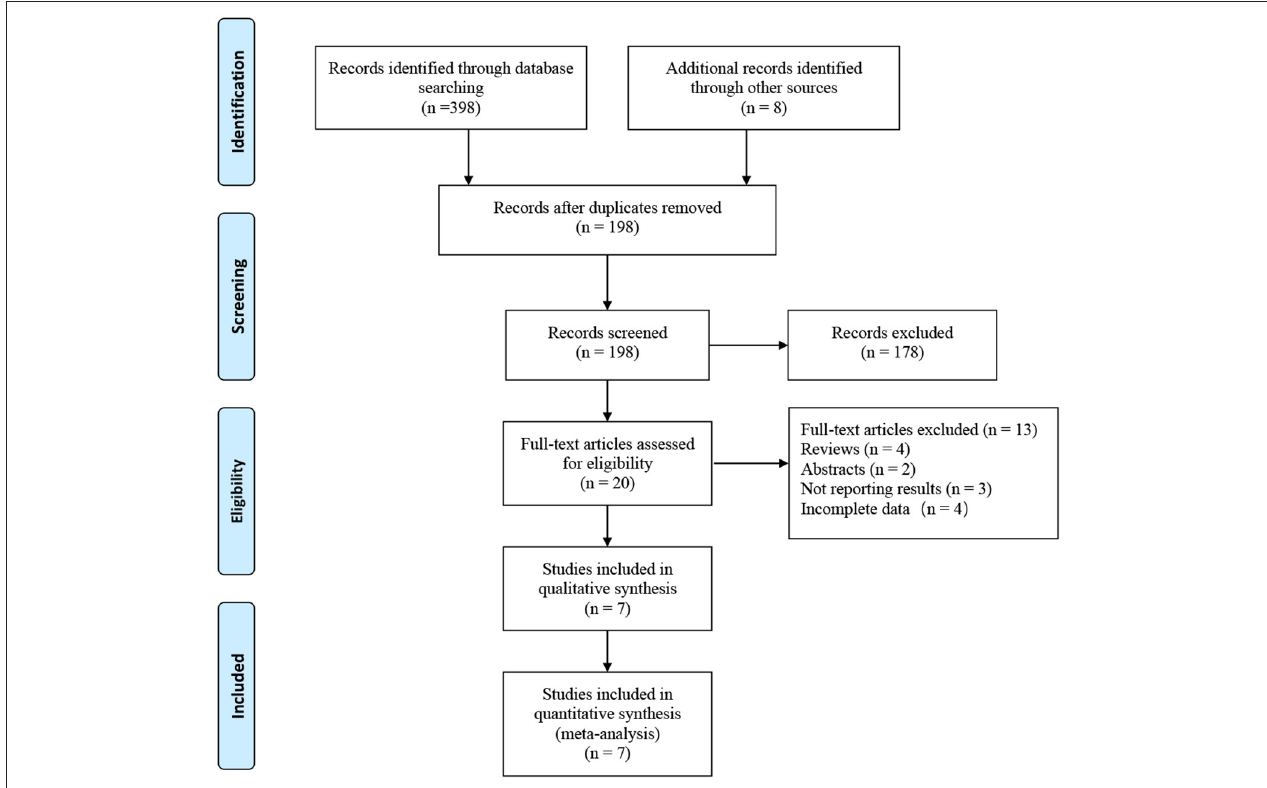
FIGURE 1 | Flow diagram of